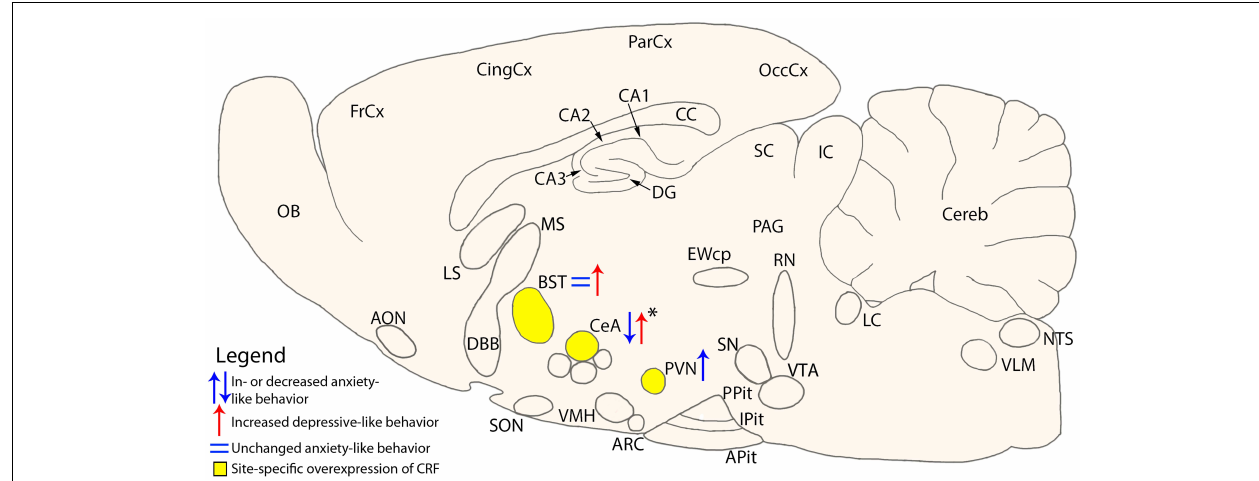
CeA, central nucleus of the amygdala; Cereb, cerebellum; CingCx, cingulate cortex; DBB, diagonal band of Broca; DG, dentate gyrus; EWcp, centrally projecting Edinger–Westphal nucleus; FrCx, frontal cortex; IC, inferior colliculus; IPit, intermediate pituitary; LC, locus coeruleus; LS, lateral septum; MS, medial septum; NTS, nucleus tractus solitarii; OB, olfactory bulb; OccCx, occipital cortex; PAG, periaqueductal gray; ParCx, parietal cortex; PPit, posterior pituitary; PVN, paraventricular nucleus; RN, raphe nuclei; SC, superior colliculus; SN, substantia nigra; SON, supraoptic nucleus;VLM, ventrolateral medulla;VMH, ventromedial hypothalamus; VTA, ventral tegmental